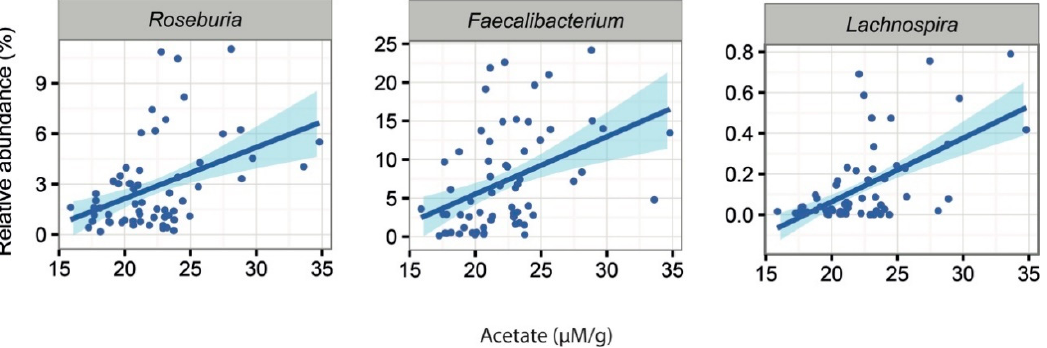
Figure 5. Significant associations between acetate and the abundance of microbial taxa in constipated